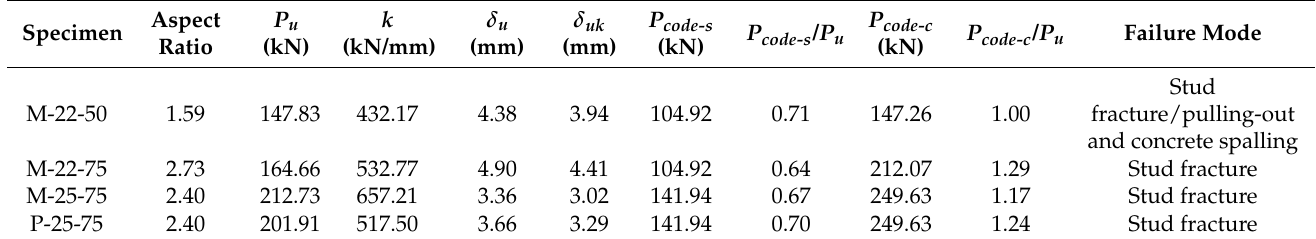
Table 2. Summary of test